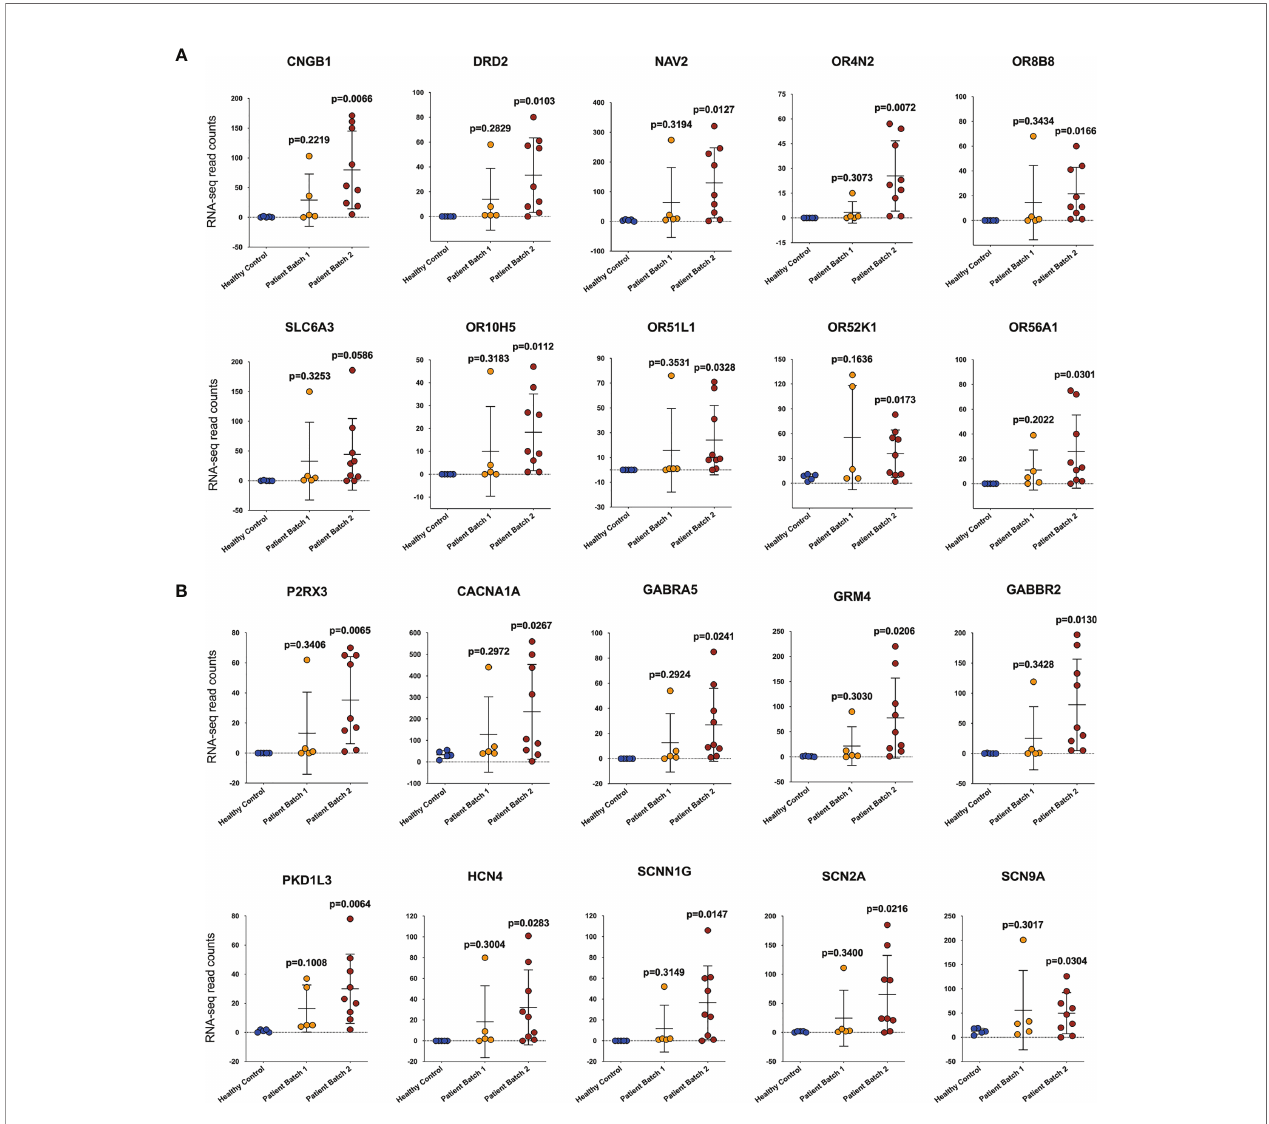
FIGURE 2 | Patients infected with SARS-CoV-2 at different periods have signi fi cant differences in genes controlling smell and taste functions. The expression of genes related to smell (A) and taste (B) function. The abscissa shows the sample source, including healthy controls (HCs) and patients from two batches, and the ordinate shows the gene transcription level by RNA-sequencing read counts. The unpaired, 2-tailed parametric t test with Welch ’ s correction was used to compare the patient group and the heathy control group. The p values were shown in each